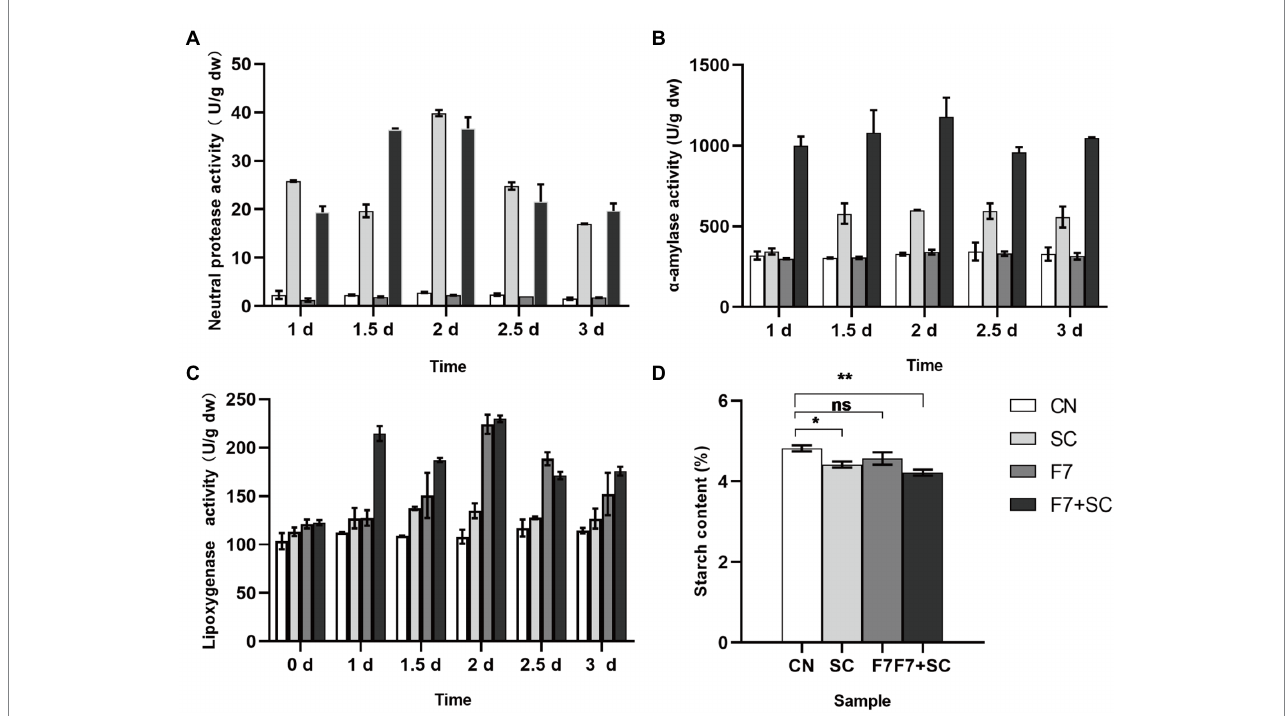
FIGURE 5 Dynamic analysis of neutral protease activities (A) , alpha-amylase activities (B) , lipoxygenase (LOX) activities (C) , and starch content (D) response to bio- inoculation. CN represents the control group. SC represents B. kochii SC mono-culture. F7 represents F. magnum F7 mono-culture. F7-SC represents F.